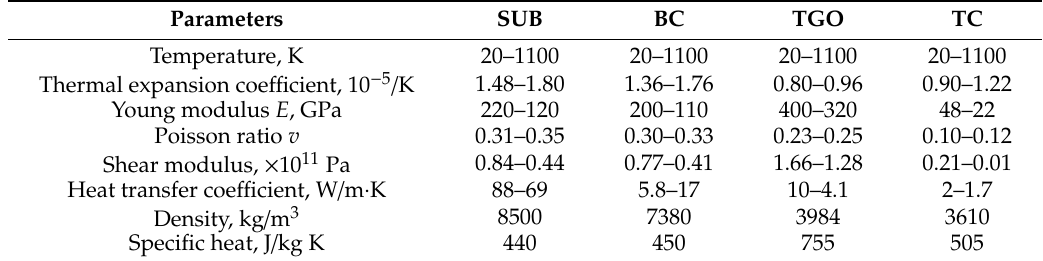
Table 1. Temperature dependent material parameters for di ff erent layers [30].